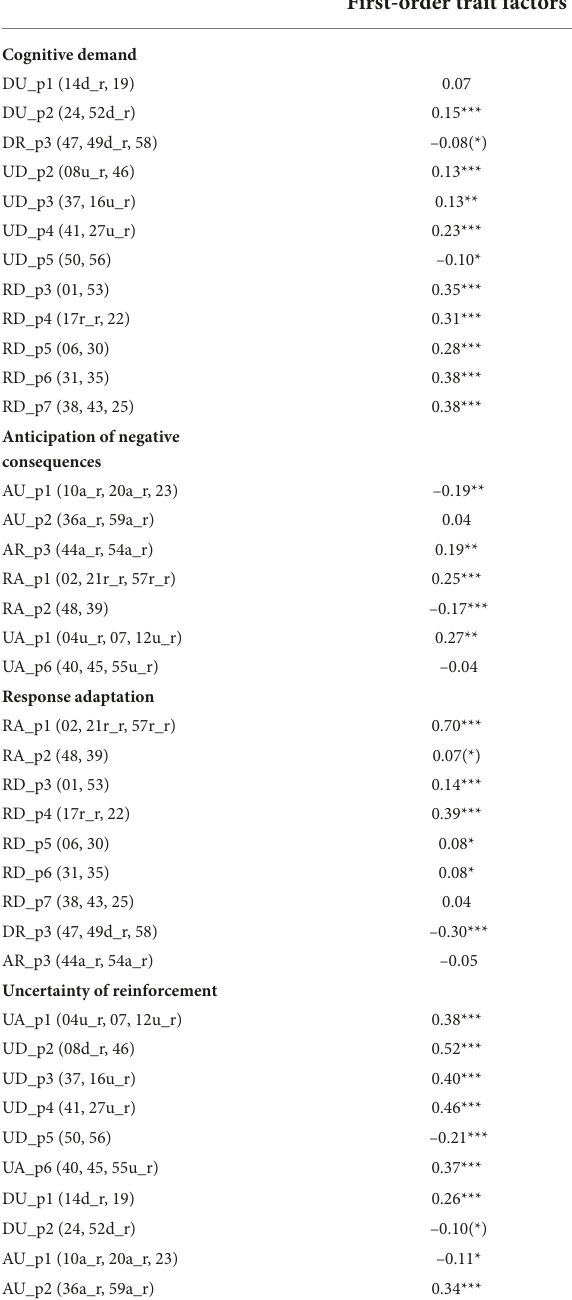
TABLE 5 Standardized factor loadings (STDYX) of the Bifactor MIMIC model of the CMQ-44 ( N = 1,076).